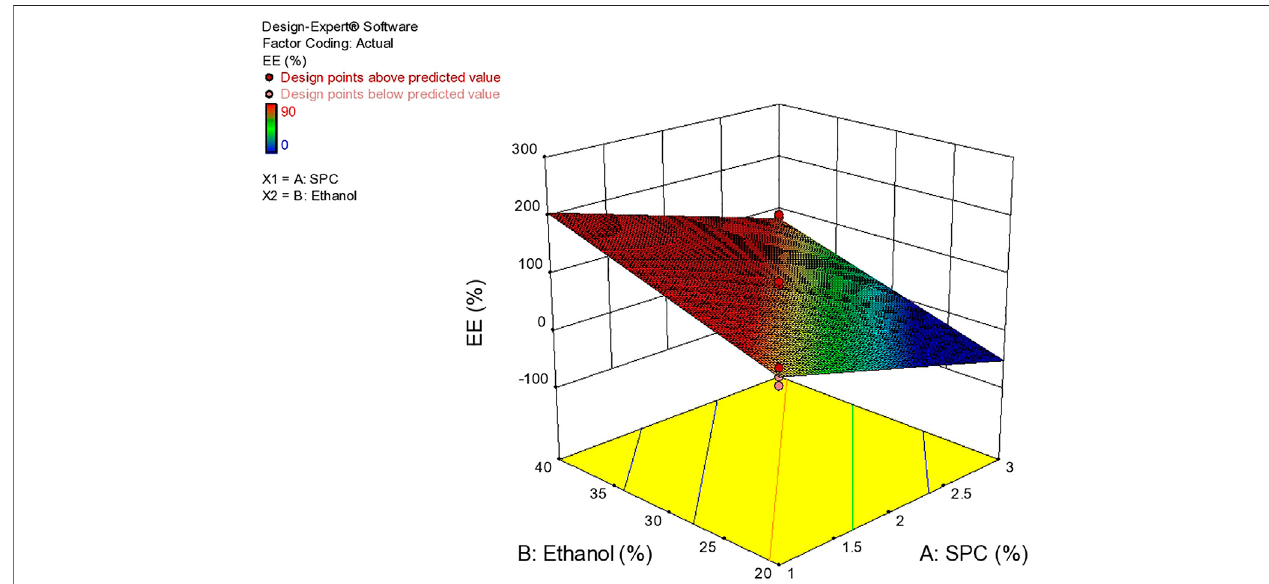
FIGURE 9 | Response surface plots showing effect of lipid and ethanolon